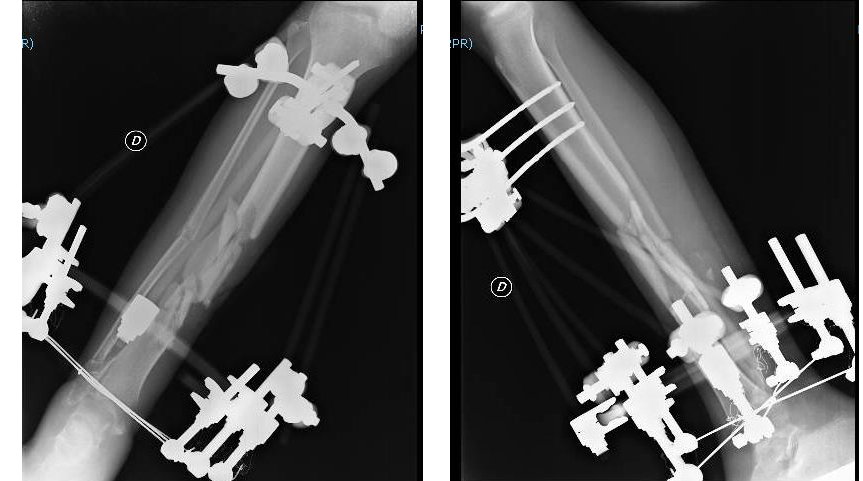
Figure 4. Radiograph at the three-month follow-up evaluation; AP and LL projections of the right leg and ankle.